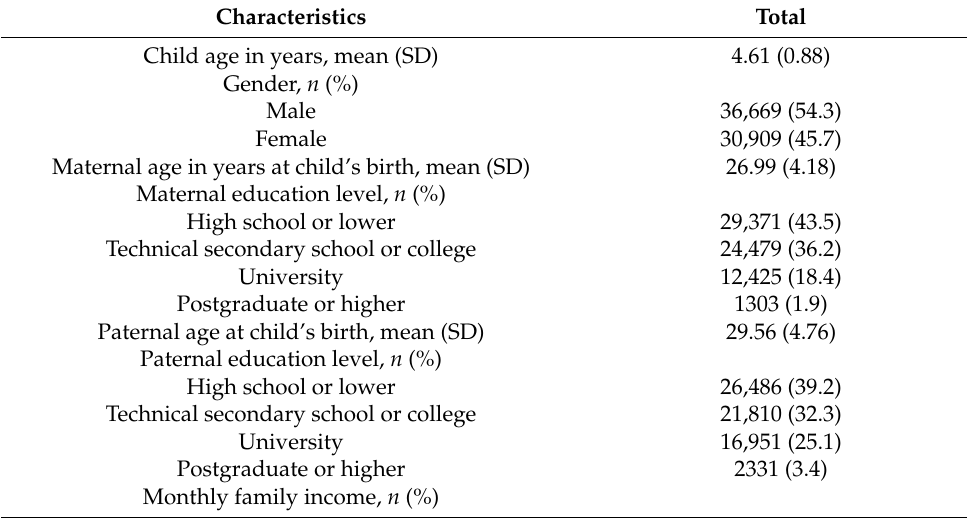
Table 1. Sample characteristics ( n =